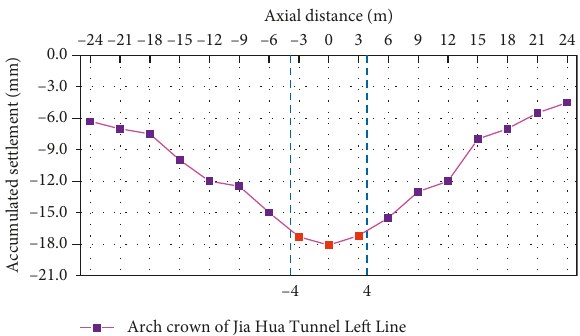
Figure 9: Accumulated settlement of Jia Hua Tunnel Left Line